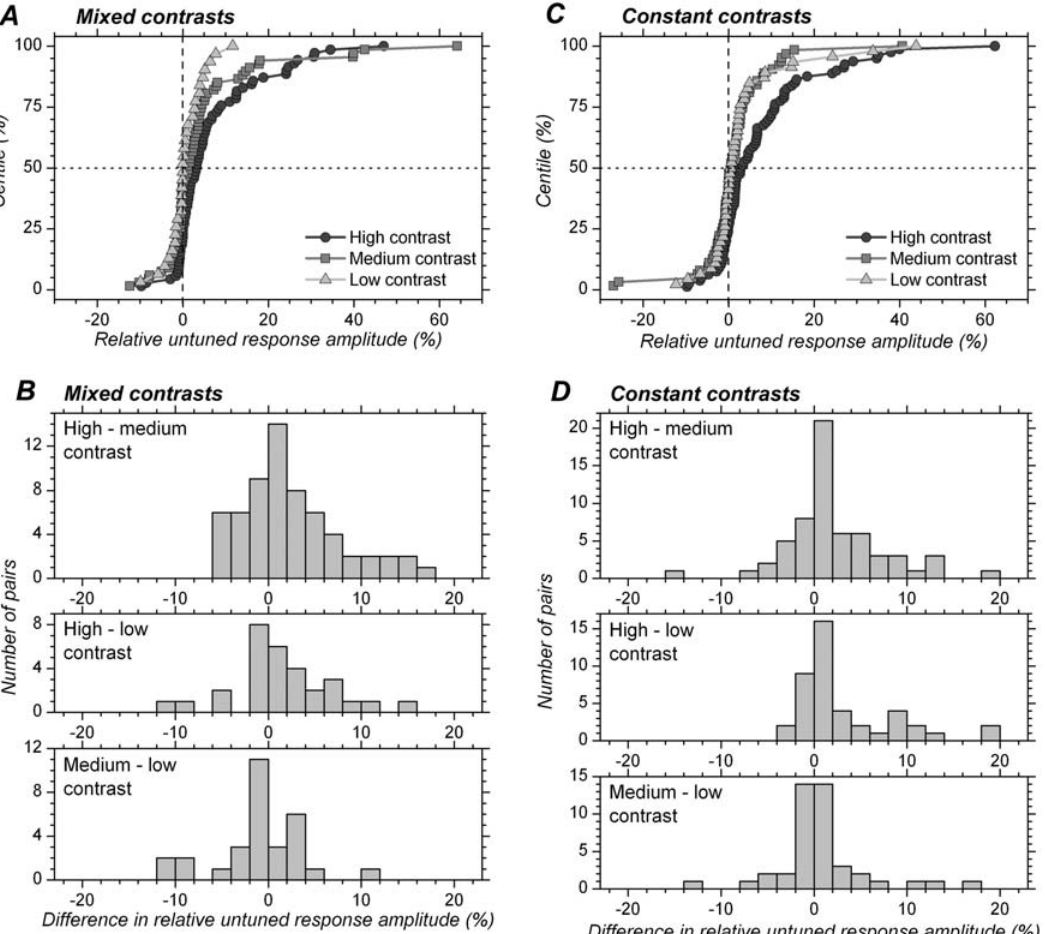
Figure 12. Changes in relative untuned response amplitude with different contrasts. A. Cumulative distribution for the three contrasts in the mixed contrasts condition. The RURA expresses the proportion of response amplitude that lacks orientation selectivity, relative to the total response amplitude. Values close to zero indicate null response to the orientation orthogonal to the preferred one. Values less than zero indicate firing rates lower than spontaneous activity, suggesting cross-orientation suppression. Values larger than zero indicate responses to orthogonal stimuli. B. Distribution of differences in RURA with different contrasts, in the mixed contrasts condition. Upper histogram: RURA obtained with high contrast minus RURA obtained with medium contrast. Middle histogram: RURA obtained with high contrast minus RURA obtained with low contrast. Lower histogram: RURA obtained with medium contrast minus RURA obtained with low contrast. At the population level, a significant difference was observed between high and medium contrast only, with larger RURA, on average, at high contrast. C. Cumulative distributions for each of the three contrasts, for the constant contrast blocks. D. Distribution of differences in RURA with different contrasts, for the constant contrast blocks. RURA values obtained with high contrast were significantly larger than those obtained with either medium (upper histogram) or low contrast (middle histogram). RURA did not differ between medium and low contrasts (lower histogram). We did not test differences in RURA at the single cell level as RURA calculation combines two parameters, each with its own associated standard